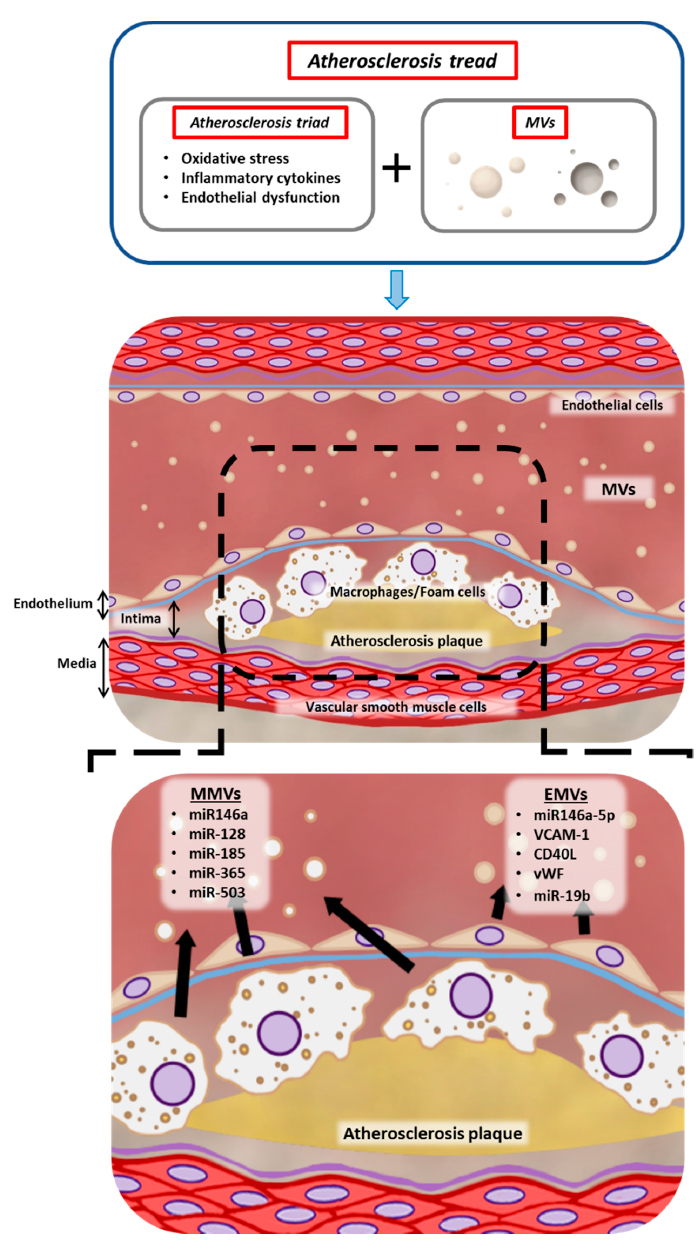
Figure 2. Contributors in the atherosclerosis development. Factors and microvesicles harbouring molecular mediators for the development and progression of the multistep process of atherosclerosis. Black arrows show miRNAs and factors released from macrophage MVs (MMVs) and endothelial MVs (EMVs). A dashed frame represents a zoom of the atherosclerosis plaque. Bi-directional arrow defines the different parts of vessels (endothelium, intima and media layers).